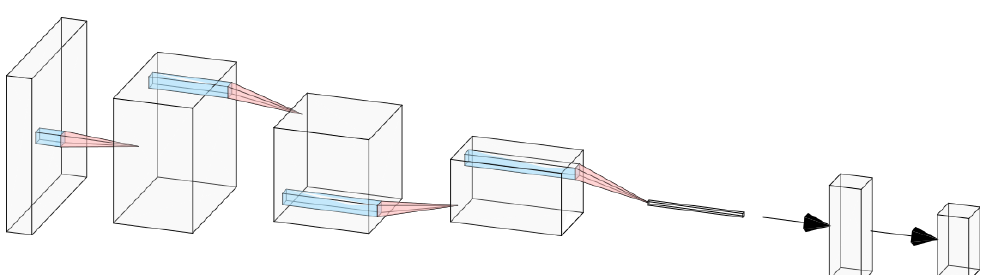
Figure 2. Architecture of the C network consisting of the input image, four convolutional layers, and two fully connected layers. The proposed method is beneficial to the network even in such minimal